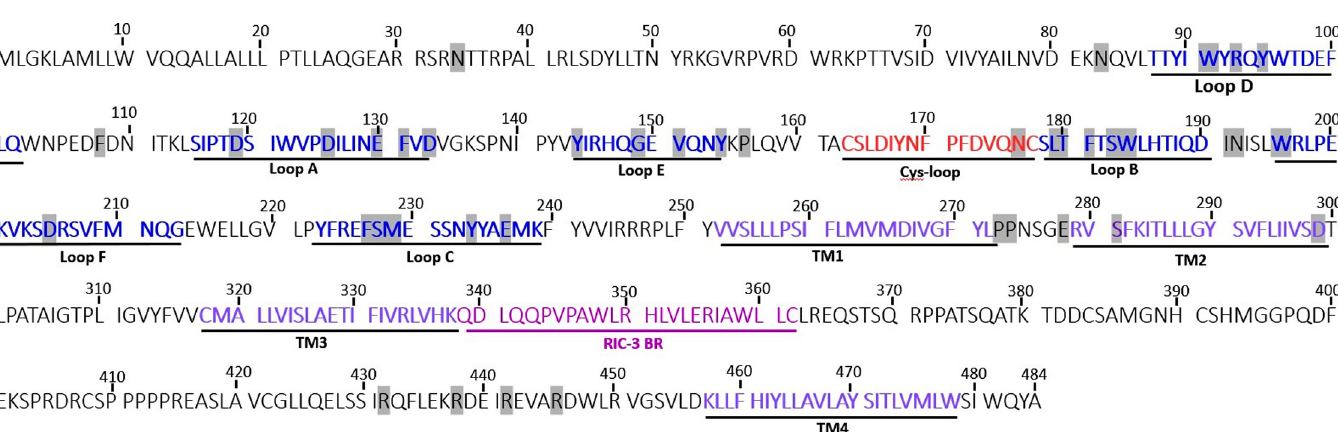
Fig 4. Amino acid sequence of the human 5HT3A subunit (AAP35868.1). The Cys-loop is marked in salmon, the extracellular loops are labelled in blue and transmembrane (TM) domains are depicted in purple, RIC-3 binding region (RIC-3 BR) depicted in pink. Functionally important amino acids as described in Table 2 are highlighted in